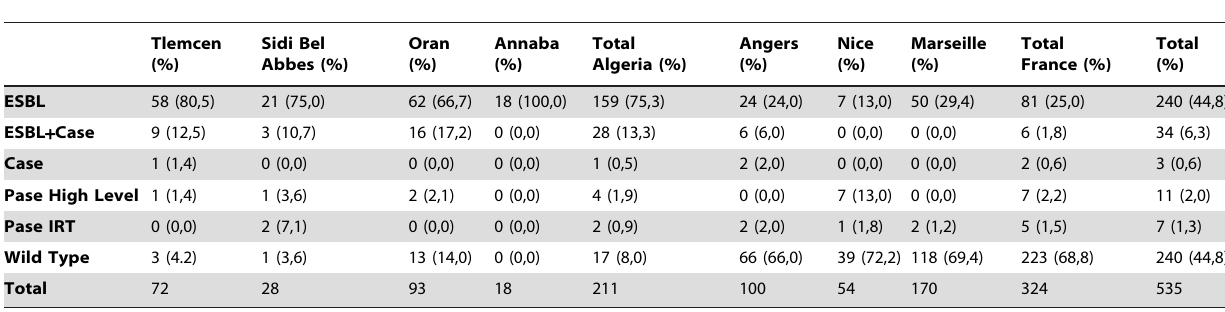
Table 3. Antibacterial resistance phenotypes of Klebsiella pneumoniae